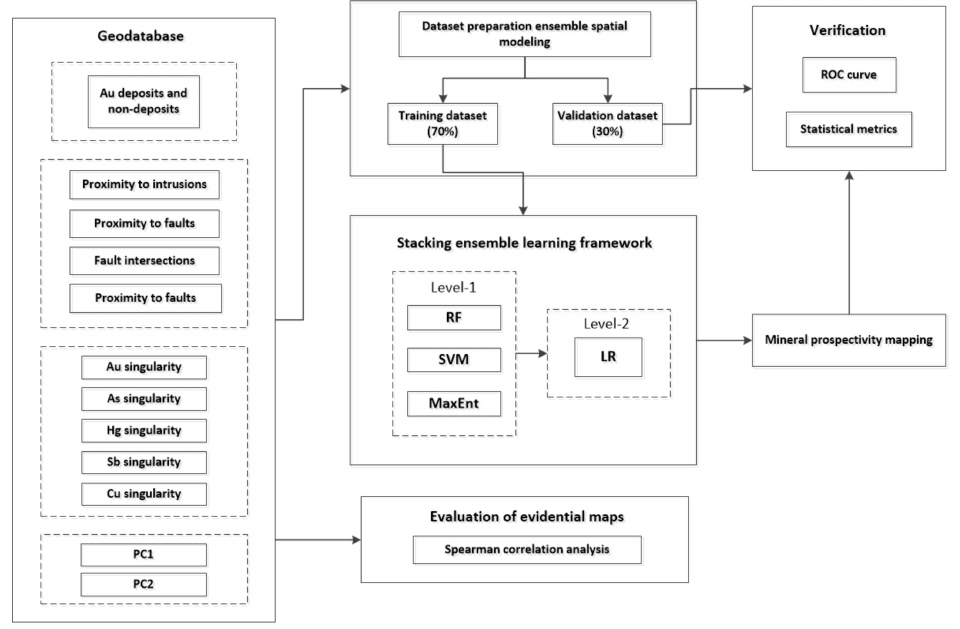
Figure 5. Flowchart of this study. RF—random forest; SVM—support vector machine; MaxEnt—maximum entropy model; LR—logistic